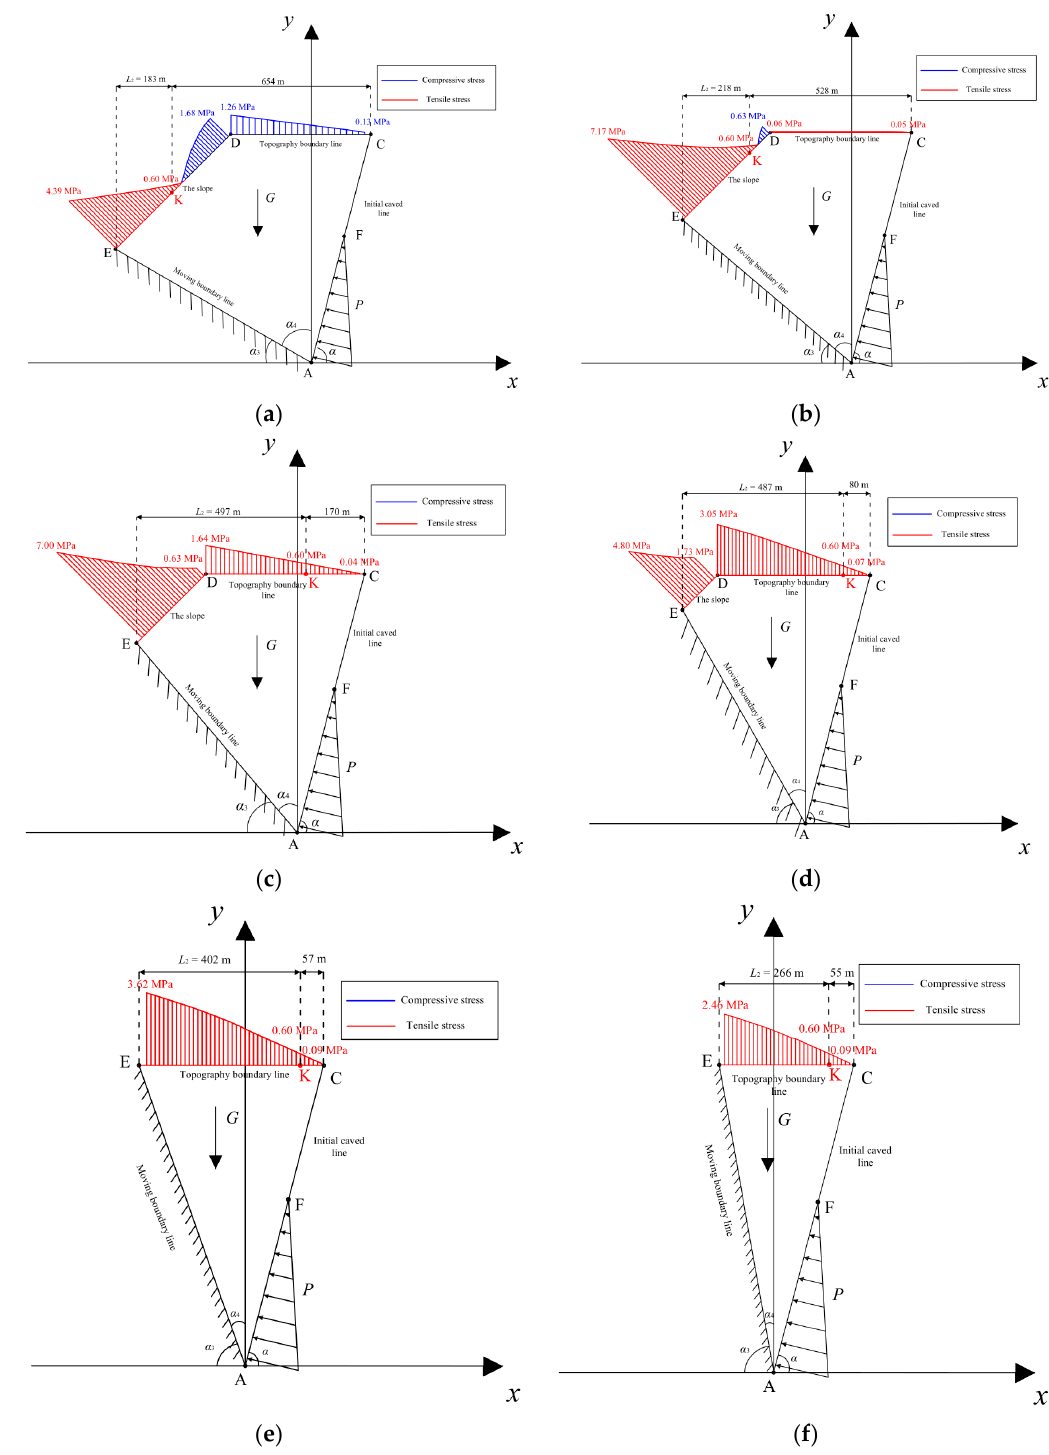
Figure 9. The calculation results of mechanical models. ( a ) α 3 = 30°; ( b ) α 3 = 40°; ( c ) α 3 = 50°; ( d ) α 3 = 60°; ( e ) α 3 = 70°; ( f ) α 3 = 80°. ( d ) α 3 = 60 ◦ ; ( e ) α 3 = 70 ◦ ; ( f ) α 3 = 80 ◦